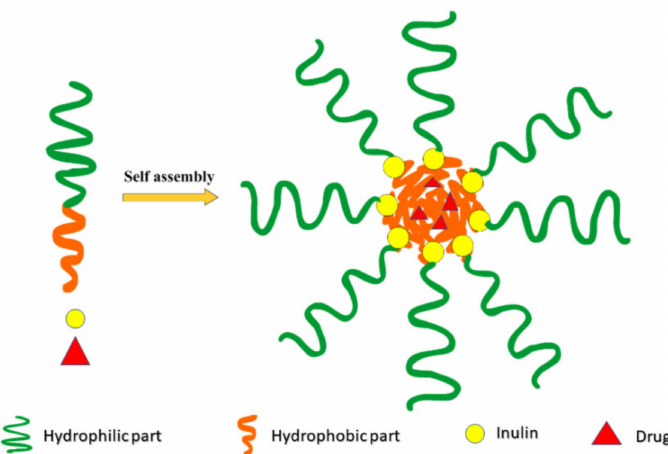
Figure 5. Inulin prodrug conjugate self-assembly into prodrug